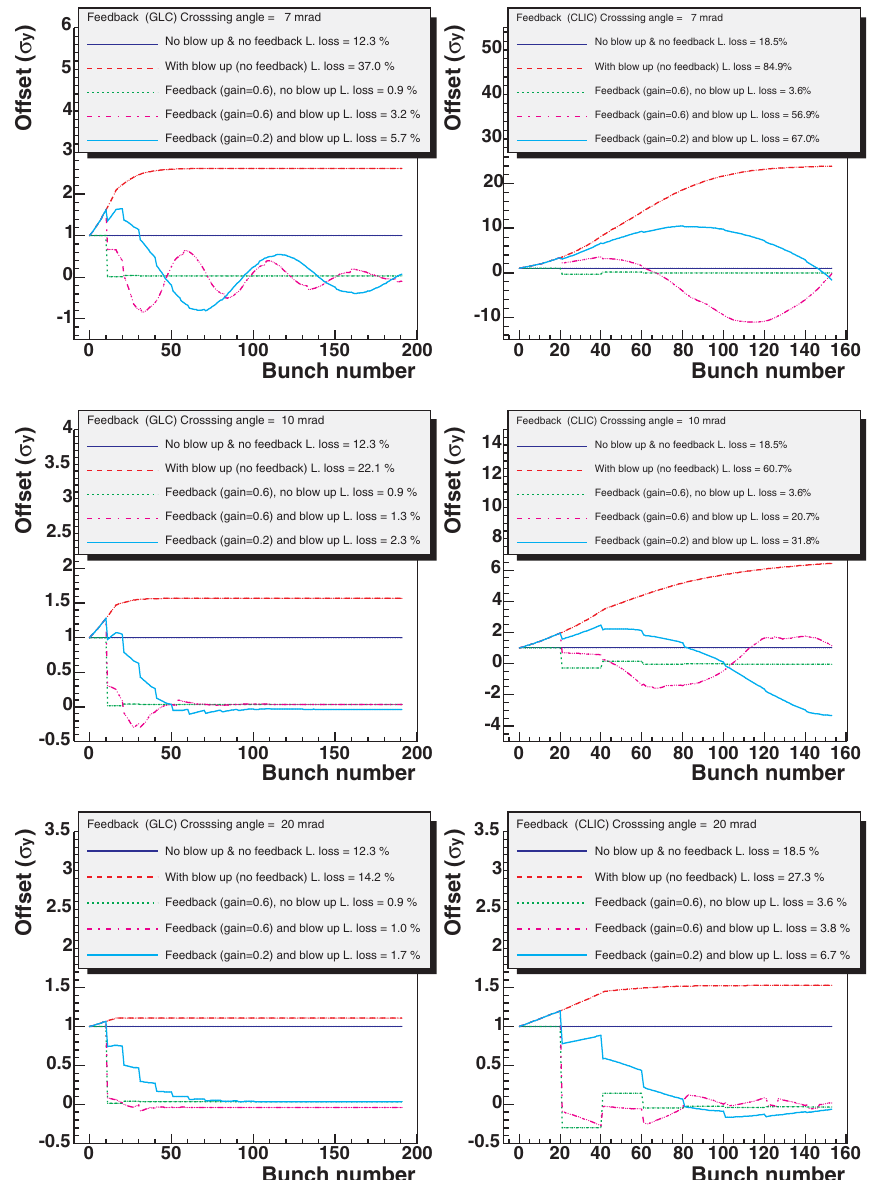
FIG. 7. (Color) Effect of the fast intrapulse feedback system on the beam blowup for different crossing angles for the GLC (left . The feedback system is assumed to be located near the last column) and CLIC (right column) for an initial beam offset of 1 (cid:1) y